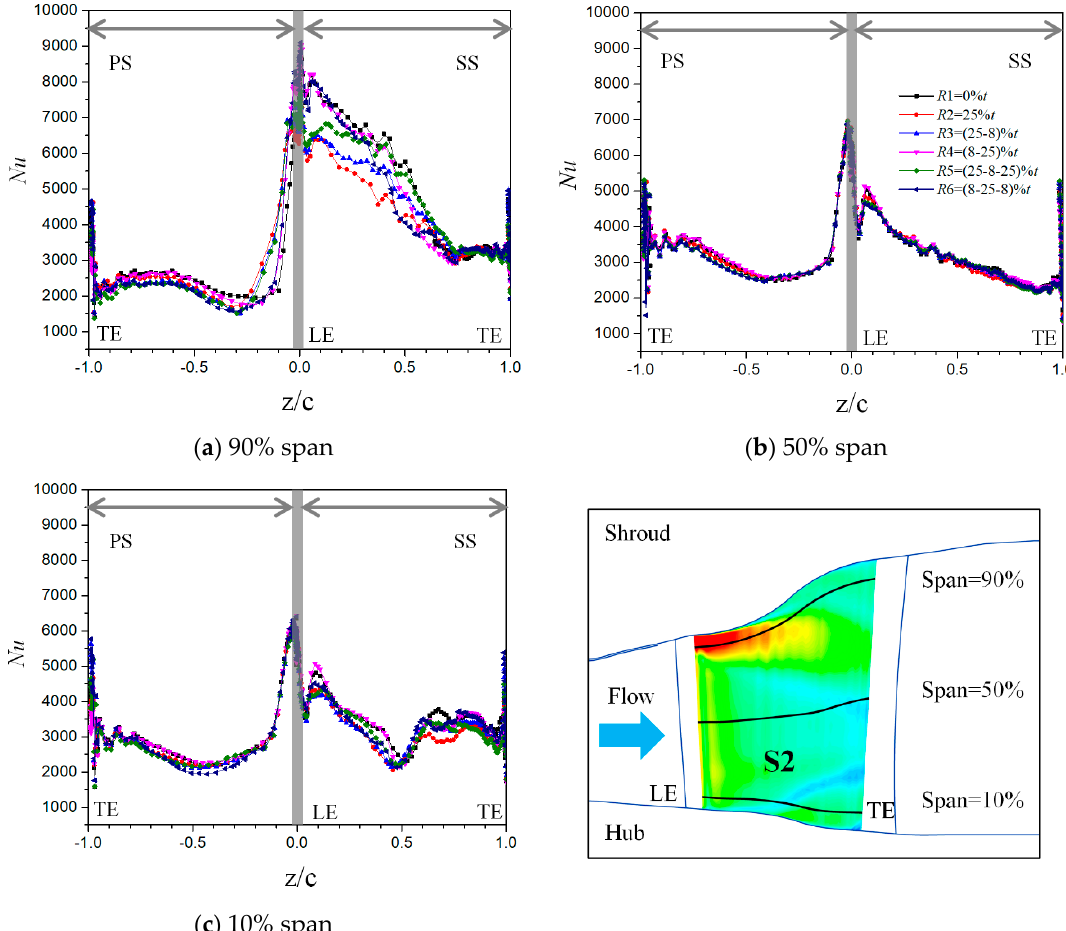
Figure 16. Nu distribution for S2 at 1% span ( a ), 50% span ( b ), and 99% span ( c ) blade.